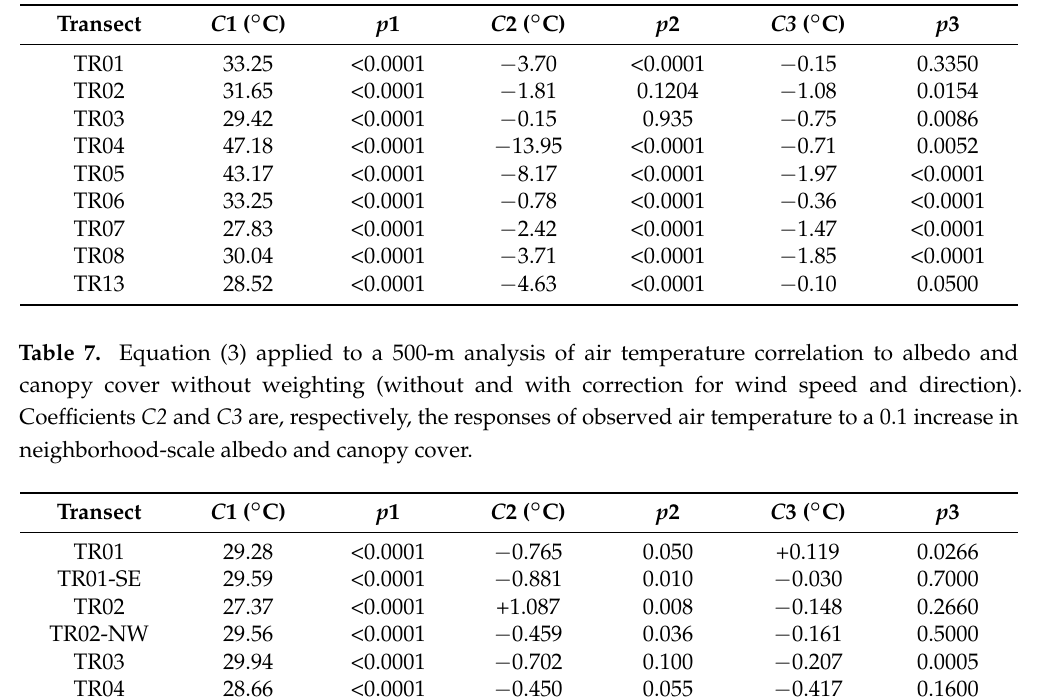
Table 6. Equation (3) applied to a 1-km Cressman-type analysis of air temperature correlation to albedo and canopy cover. Coefficients C2 and C3 are, respectively, the responses of observed air temperature to a 0.1 increase in neighborhood-scale albedo and canopy cover.